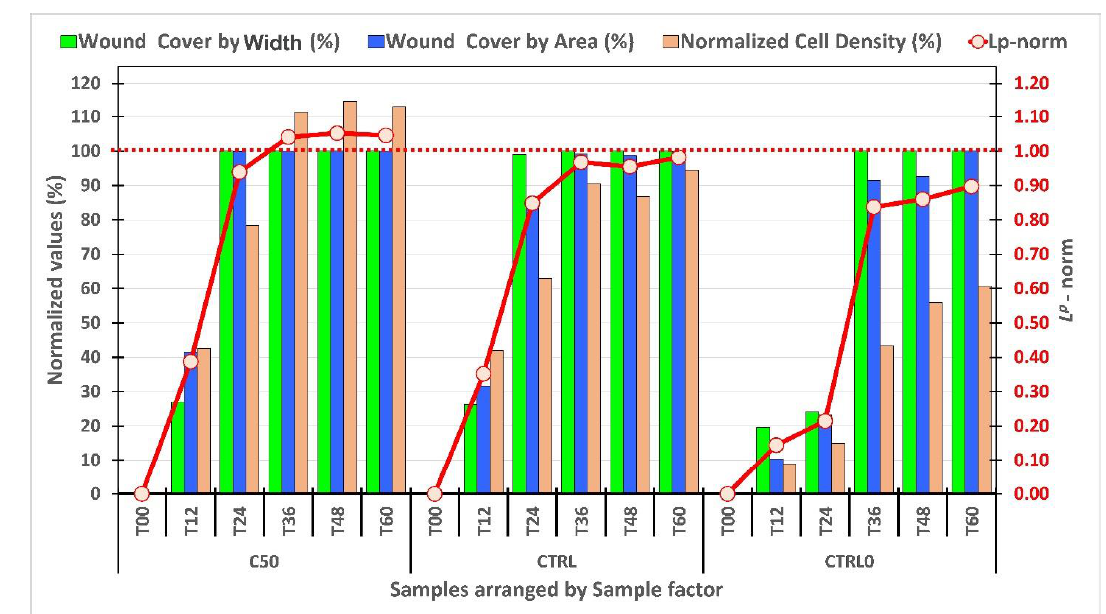
Figure 3. Evolution of the migration of fibroblasts and “gap coverage” (which is similar to wound closure), with respect to the statistical factor “Sample” (average values). The quantitative parameters were: wound closure by width, wound closure by area and normalized cell density inside the wound.